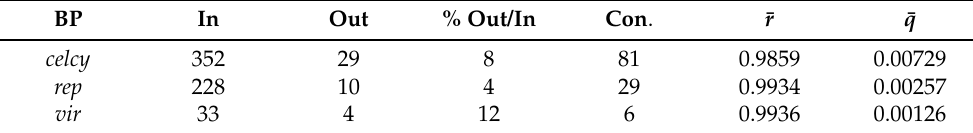
Table 1. Summary of results for GFN estimation.